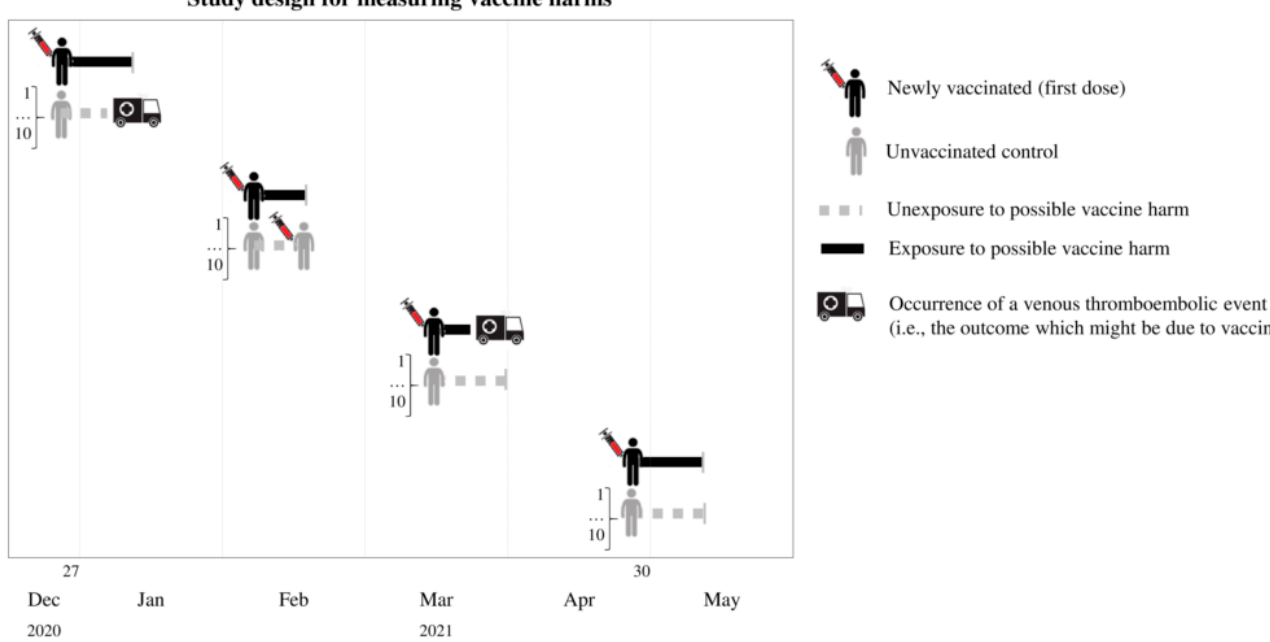
Figure 2. Study design for measuring vaccine harms.